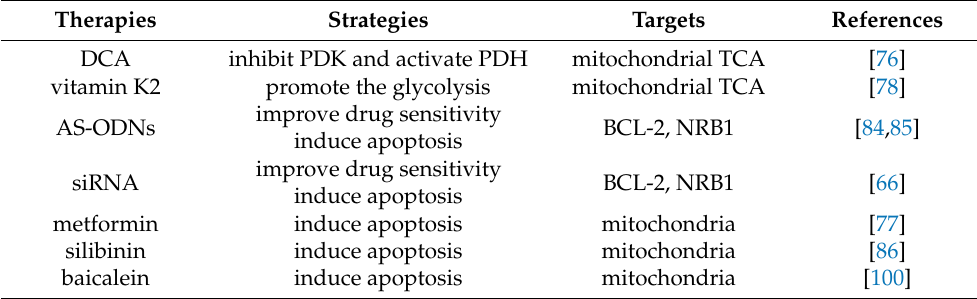
Table 1. Mitochondria-targeted therapies for UC. Therapies Strategies